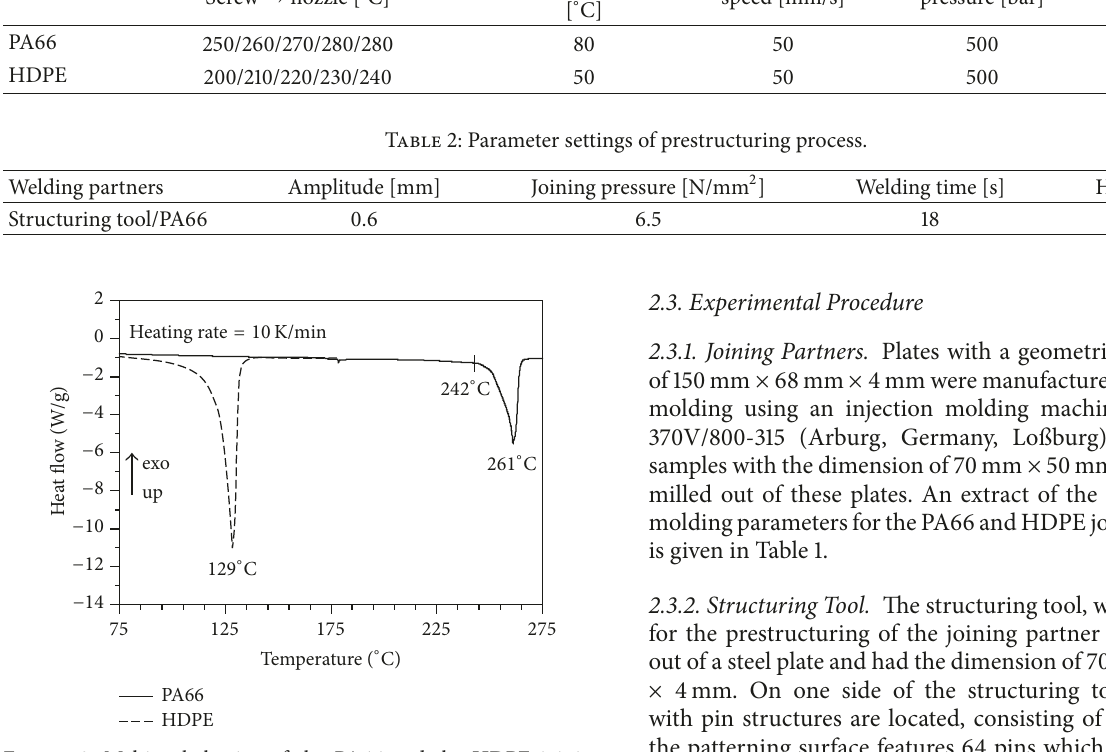
Figure 2: Melting behavior of the PA66 and the HDPE joining